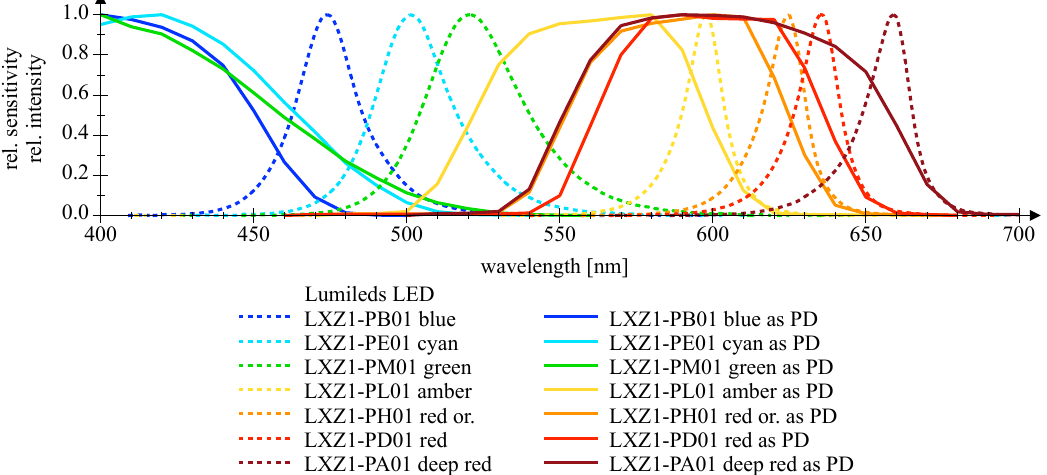
Figure 10. Normalized spectral measurements of Lumileds Z series LED, deployed as emitter (dashed lines) and as detector (solid lines), respectively.